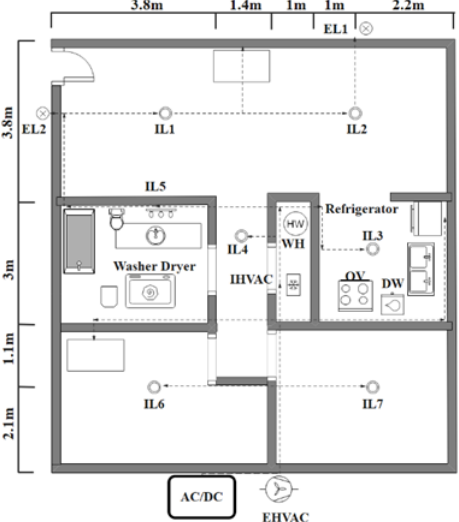
Figure 2. Battery storage unit configuration.